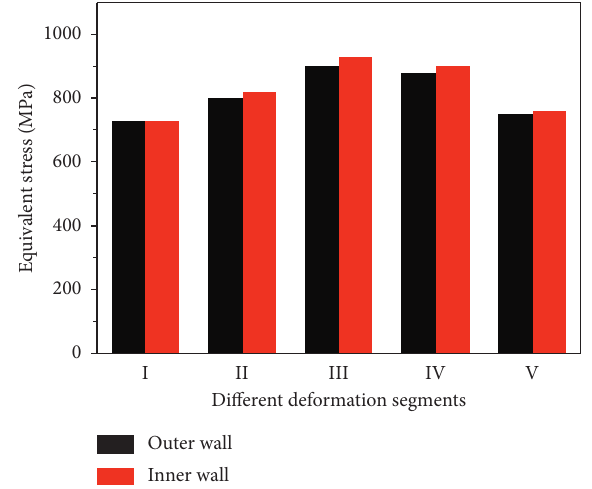
Figure 9: Contrast of inner and outer wall average equivalent stress in the deformation